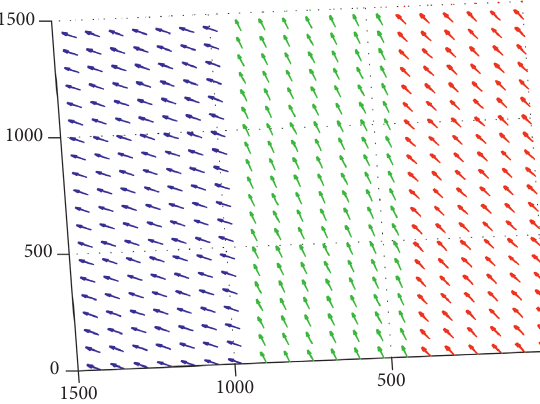
Figure 1: The schematic diagram of wind